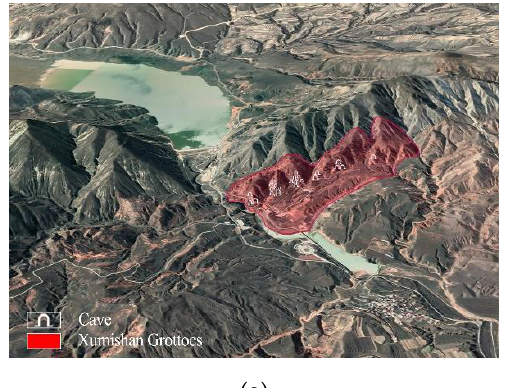
( f ) Figure 6. Normalized mean wind speed around the canopy with different widths in cross section of y/H = 0, ( a ) W = 0.1 H, ( b ) W = 0.3 H, ( c ) W = 0.5 H, ( d ) W = 1 H, ( e ) W = 2 H, ( f ) W = 3 H. The dotted line rectangular marks the canopy region occupied by trees. As shown in Figure 6, the shelter efficiencies expressed in the minimal wind speed U min/ U ref on the leeward side of the windbreak and its location x min changes little for dif- ferent widths. The principal reason for this is the compensation between the permeability and the downstream perturbed pressure of the canopy. In order to save forest resources, a width of 0.3 to 0.5 H for shelterbelts with a rectangular cross-section is suggested. 3.4. Flow Fields around Shelterbelt over a Real Complex Terrain The Xumishan Grotto Zone is located at about 105°58 ’ 46 ”– 105°59 ’ 21 ” E, 36°16 ’ 13 ”–